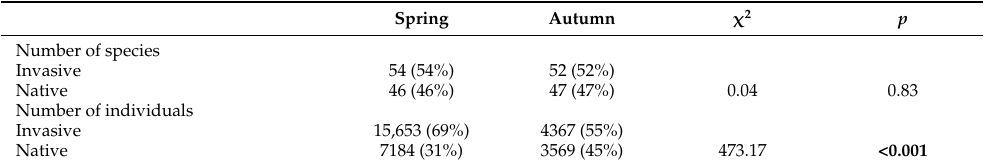
Table 5. Chi-square test results for the comparison in the proportion of invasive species to native species during spring vs. autumn across all sites. Bold p -values indicate statistically significant